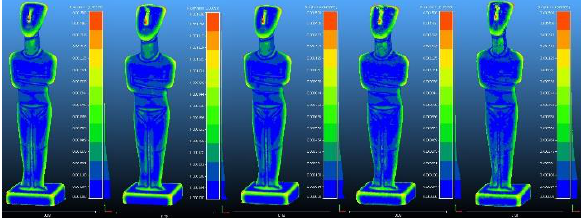
Figure 7: Agisoft Metashape OBJ1 meshes roughness index maps (from left to right) P30, SL1 VIS, SL1 full, SL1 UVAb, SL1 IRA (calculated for neighbourhoods of 0.5 cm 2 )